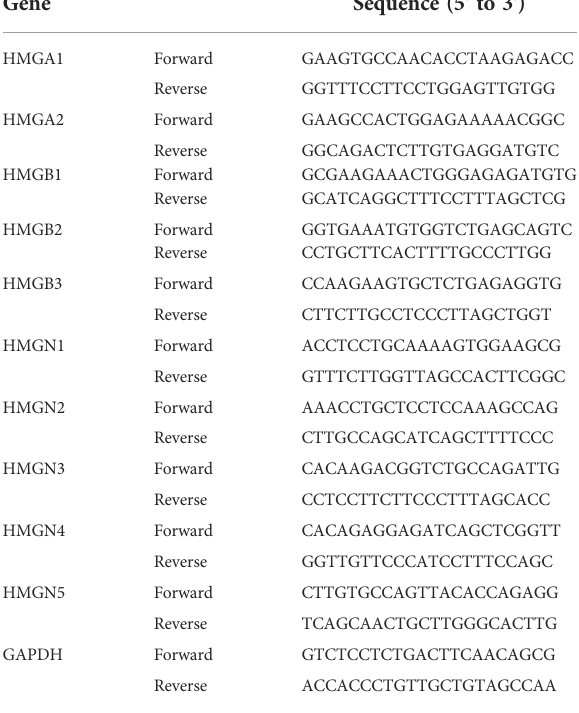
TABLE 1 Sequences of primer pairs for target genes used in the qRT-PCR. Gene Sequence (5' to